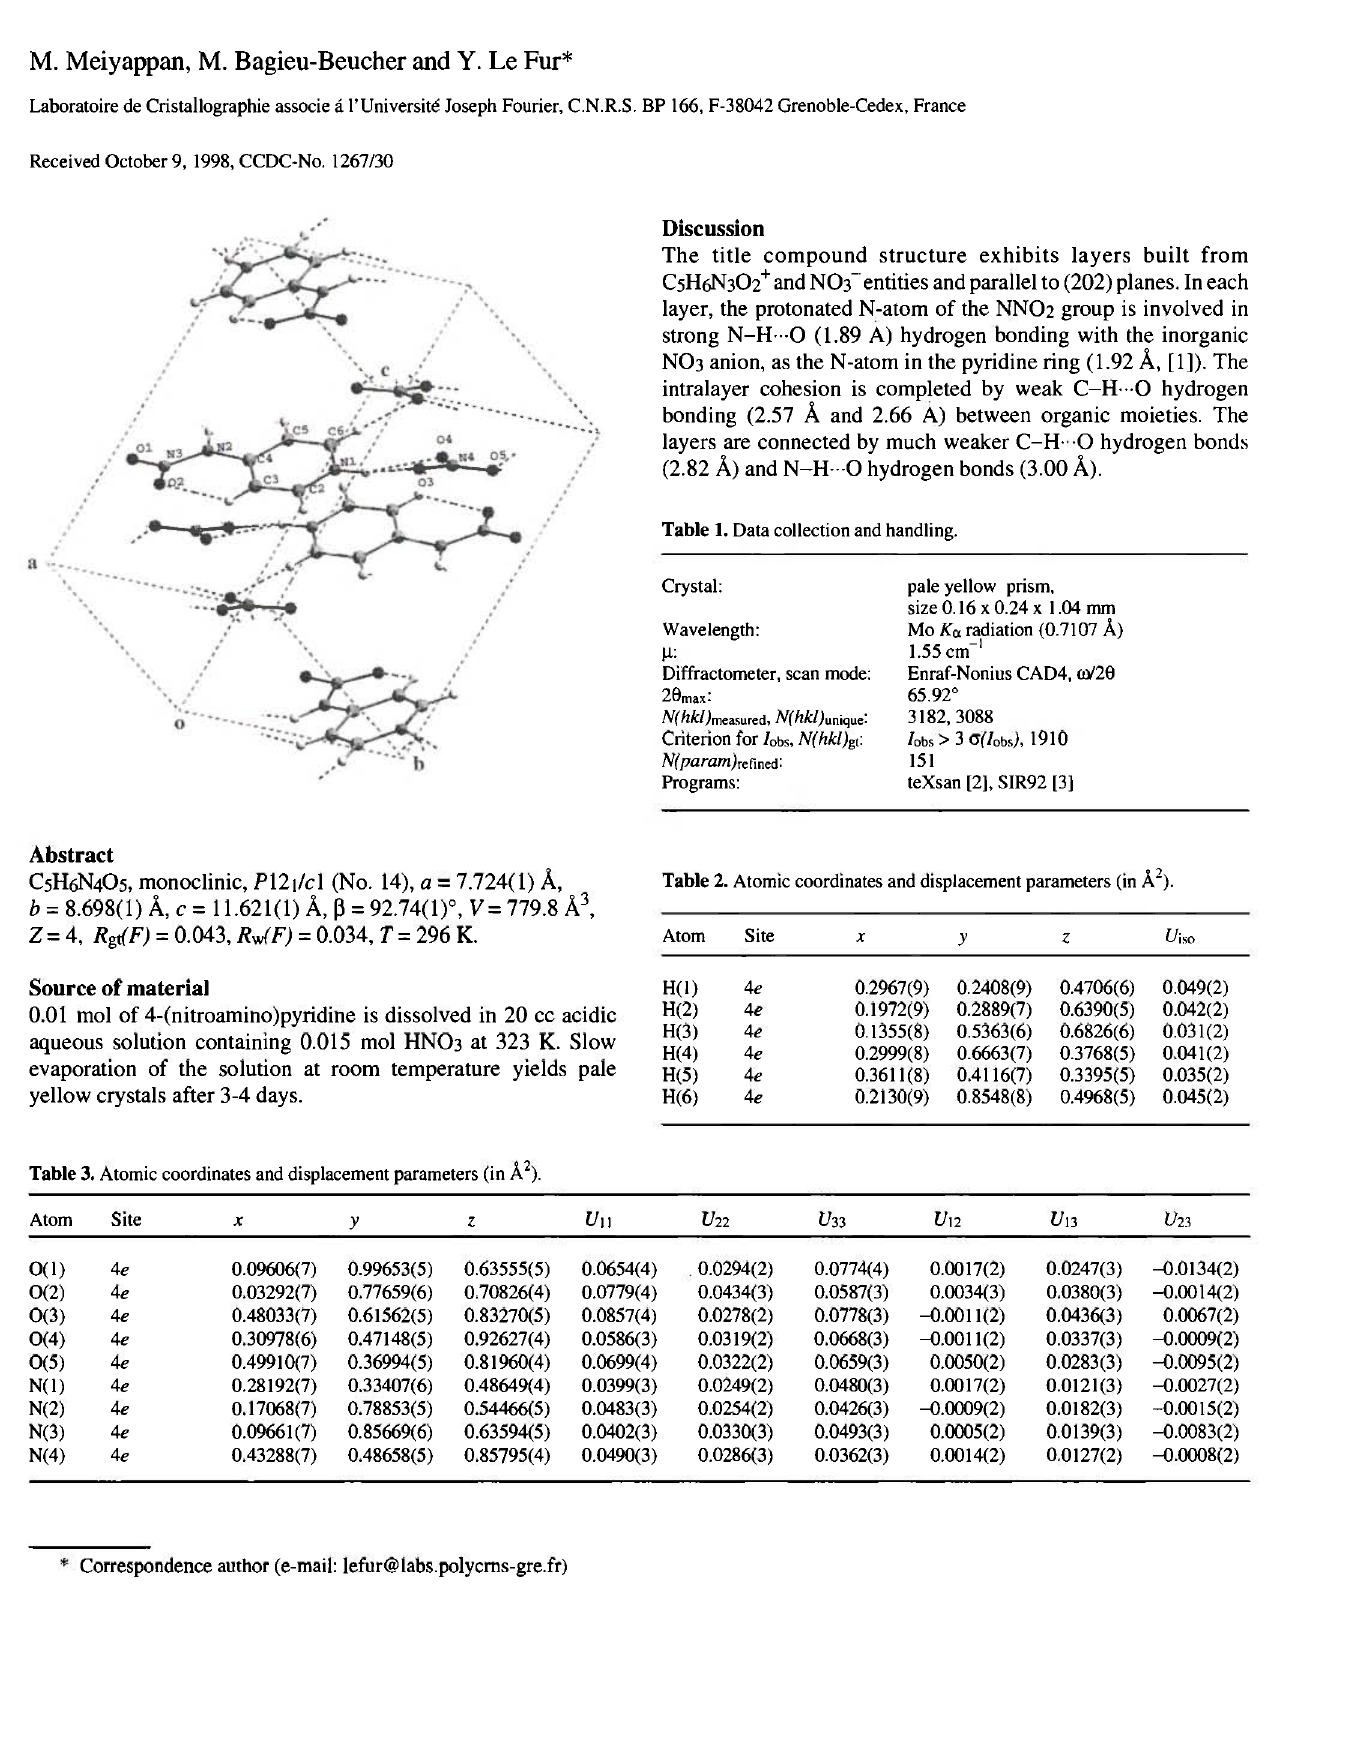
Table 3. Atomic coordinates and displacement parameters (in Ä 2 ).